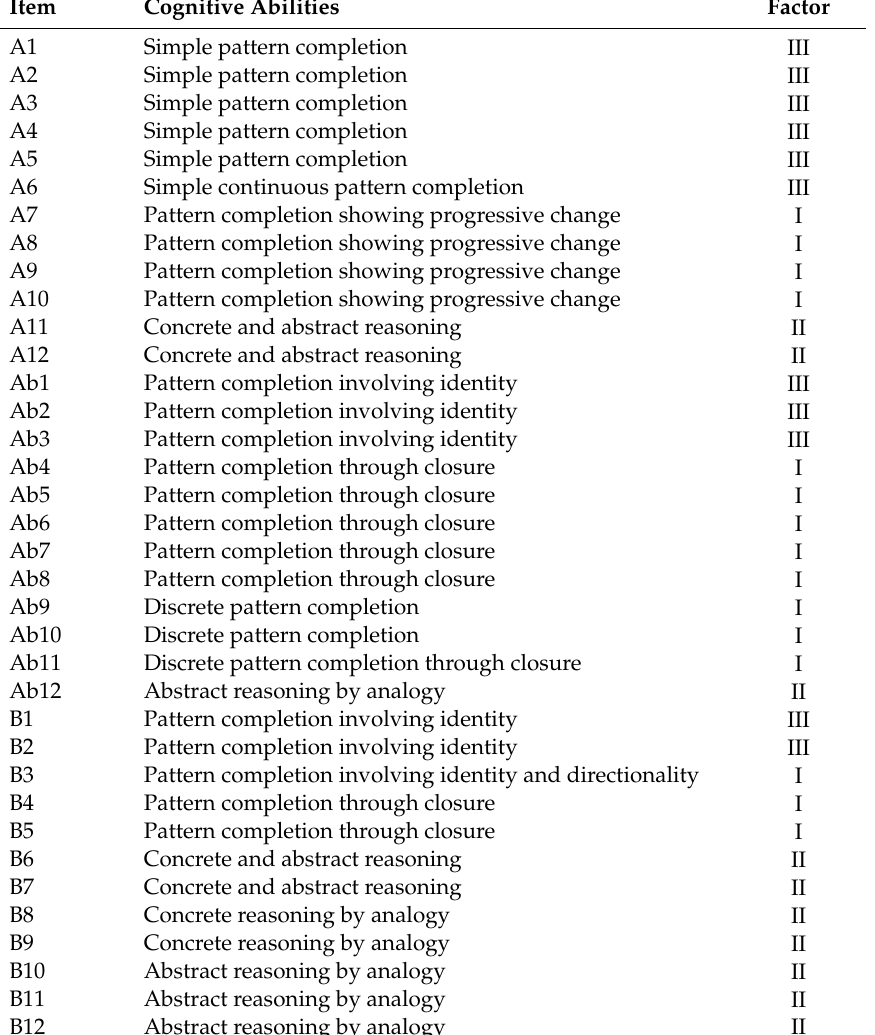
Table 2. Carlson and Jensen [53] and Wiedl and Carlson [54] factorial structure of RCPM.